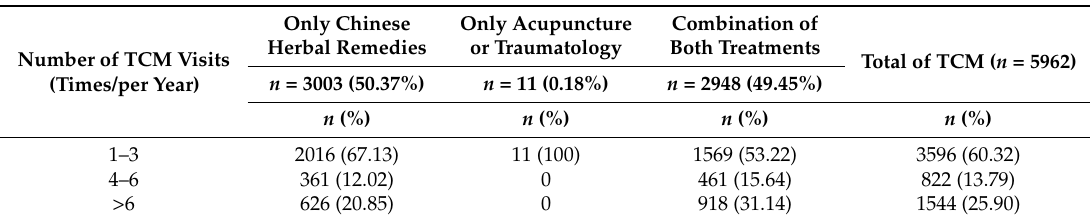
Table 2. Distribution of Chinese medicine according to type of Chinese medicine treatment received in women with PCOS, stratified by number of outpatient visits.